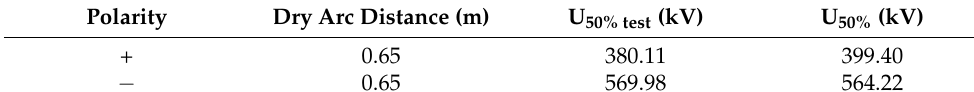
Table 2. Positive- and negative-polarity U 50% of Basalt fiber composite cross arms.